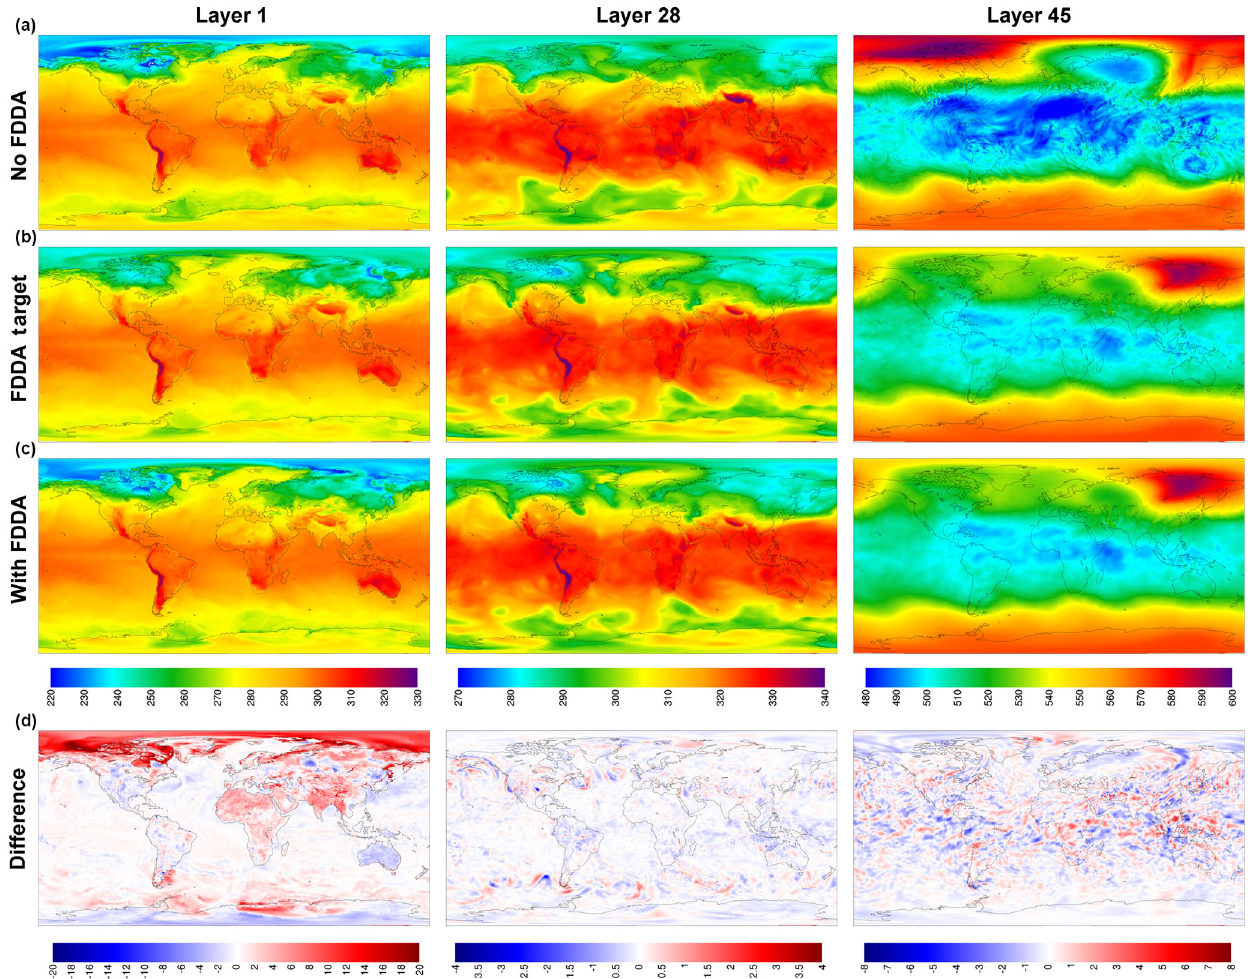
Figure 2. MPAS-A simulation results without FDDA (a) , FDDA target fields (b) , MPAS-A results with FDDA (c) , and FDDA target minus MPAS-A with FDDA (d) for potential temperature (K) in layers 1, 28, and 45, for 00:00UTC on 11 January 2013, 10 days into the